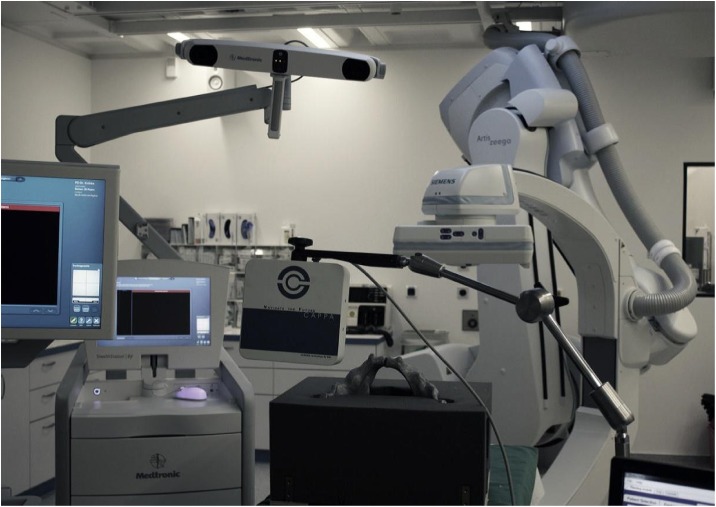
Navigation setup.Illustration of the navigation setup.